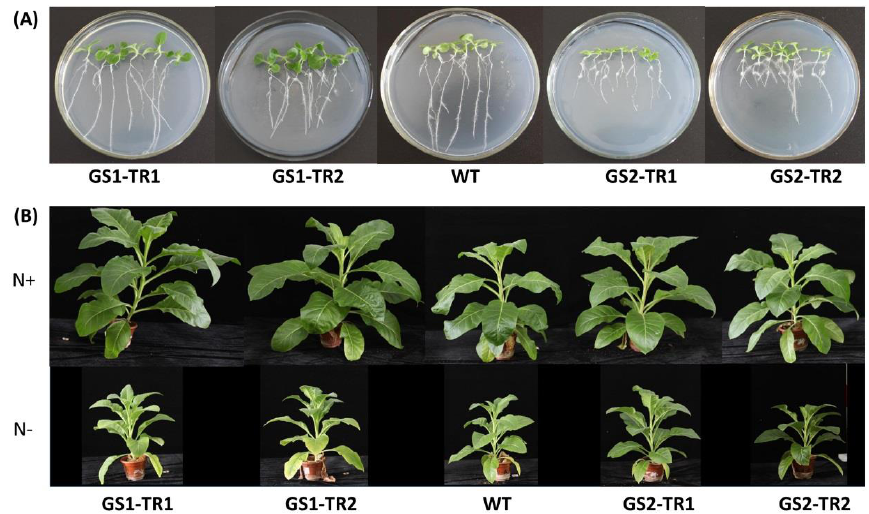
Figure 7. Qualitative growth phenotypes of transgenic and WT plants. ( A ) Comparison of seedlings from the WT and transgenic tobacco GS1-TR and GS2-TR. The plants were germinated and grown for 20 days in Murashige and Skoog (MS) medium as described in Materials and Methods section. ( B ) The phenotype of transgenic tobacco GS1-TR and GS2-TR, compared with that of the WT, after 7 weeks of growth under nitrogen-sufficient (N+) and nitrogen-starvation (N − ) conditions.